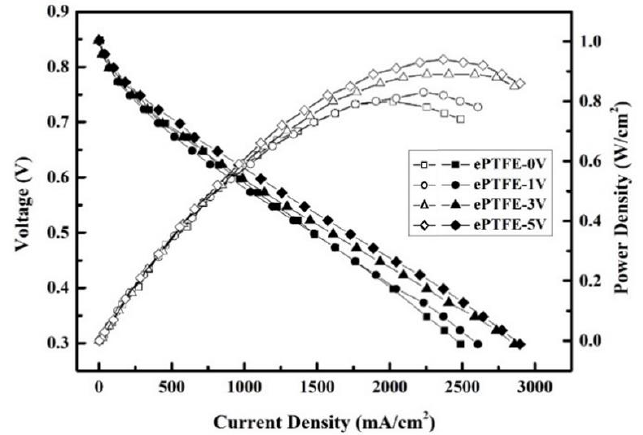
Figure 13. Fuel cell component efficiency of ePTFE membranes at the intake temperature of 80 °C and relative humidity of 100%RH.